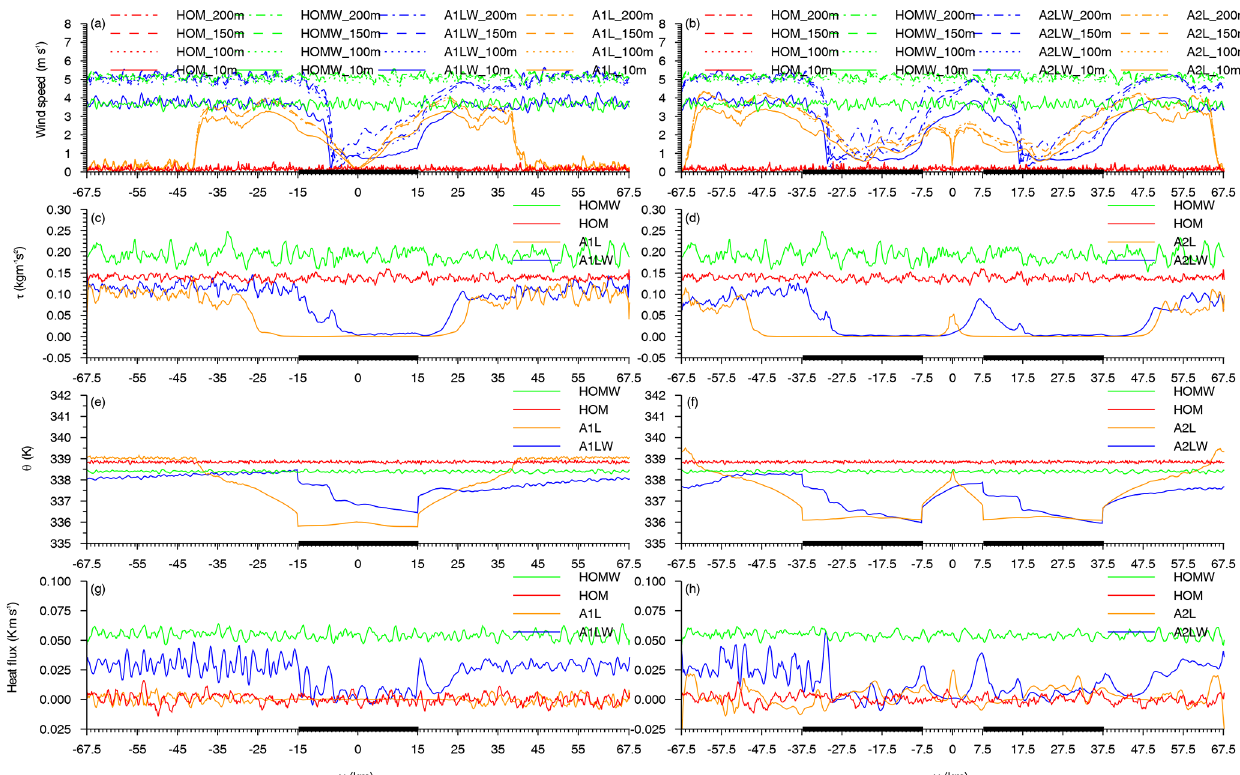
Figure 11. Variations in the wind speed (a, b) , Reynolds stress (c, d) , potential temperature (e, f) , and heat flux (g, h) in the horizontal direction below 200m for the cases with (blue and green lines) and without (yellow and red lines) background wind over homogeneous (red and green lines) and heterogeneous (blue and yellow lines) surfaces. Thick black lines represent the lake patches.